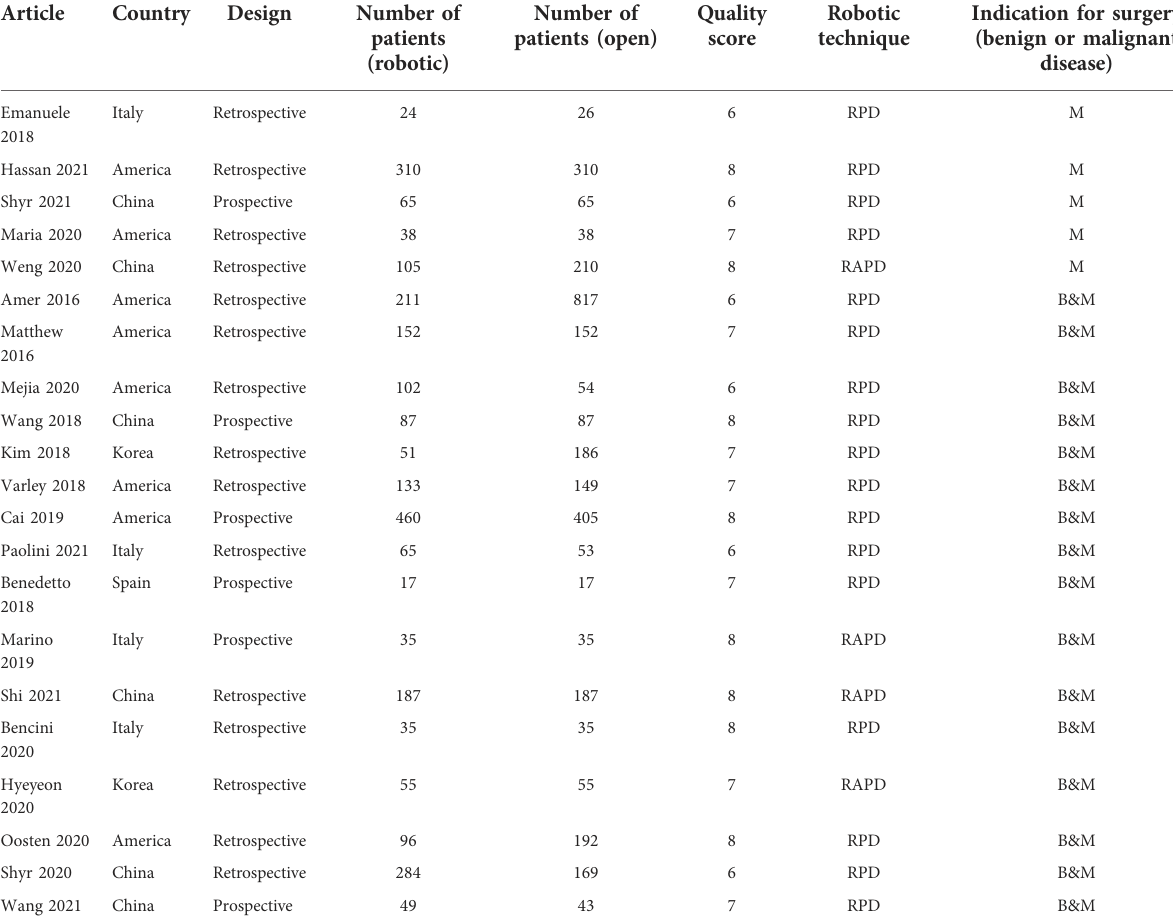
TABLE 1 Characteristics of the included studies and quality